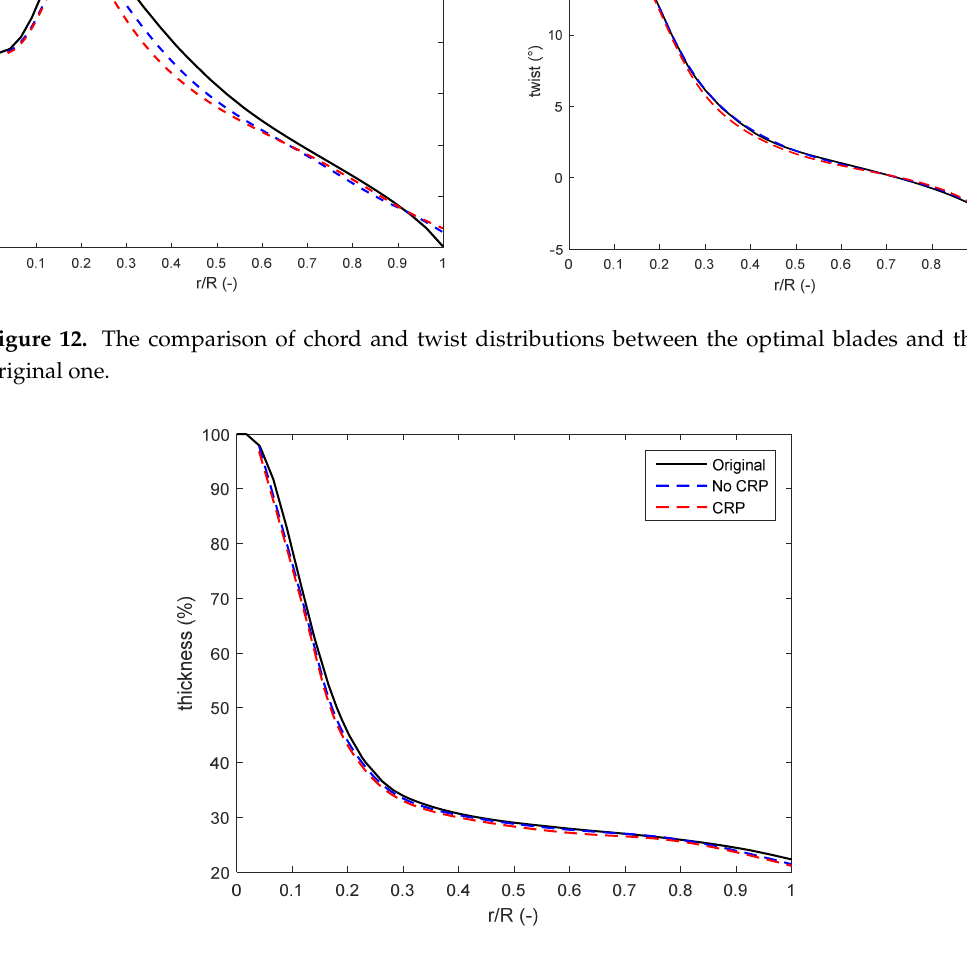
Figure 14. Weibull probability distribution of wind speed (6 m/s, 6.2969 m/s and 6.3288 m/s). Figure 15 shows the comparison of the annual energy production between the optimal blades and the original one. Due to the differences of the Weibull distribution of the average wind speed at the hub height, the shape curve of the energy production between the original wind turbine and the optimal ones is not proportional. The energy production of the optimal wind turbine is slightly less than the original blade with a range of 3 m/s to about 8 m/s wind speed and is much higher from a speed of about 8 m/s to cut out speed (20 m/s). The results indicate that the AEP of the wind turbine